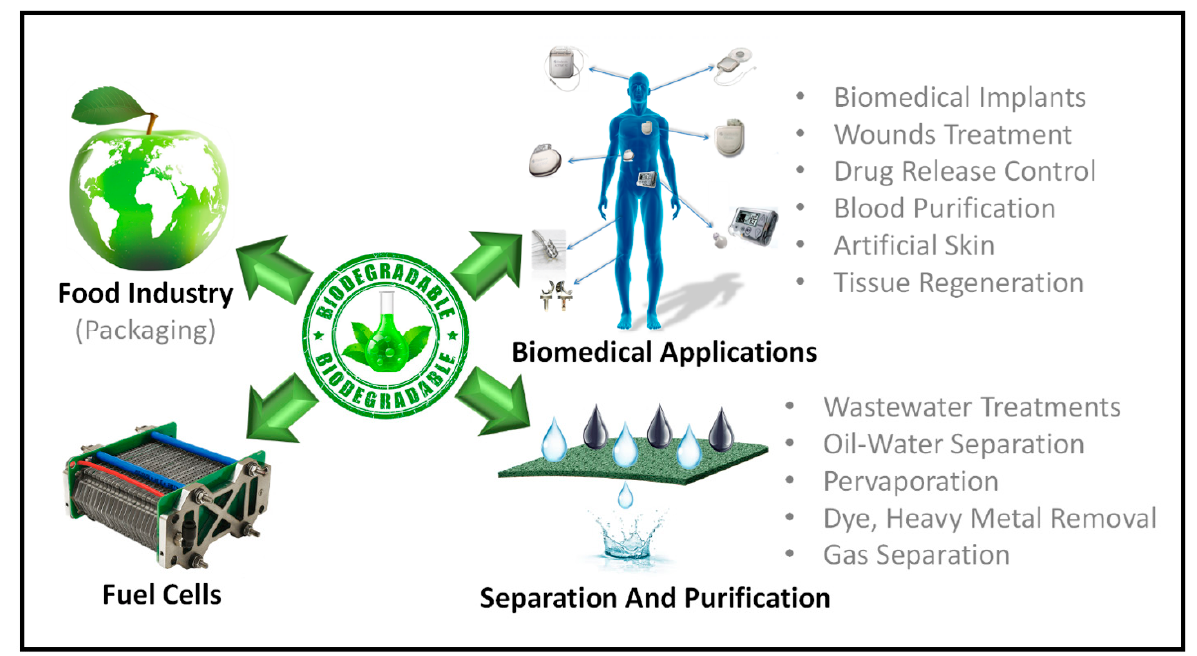
Figure 11. Applications of biodegradable polymers-based membranes.